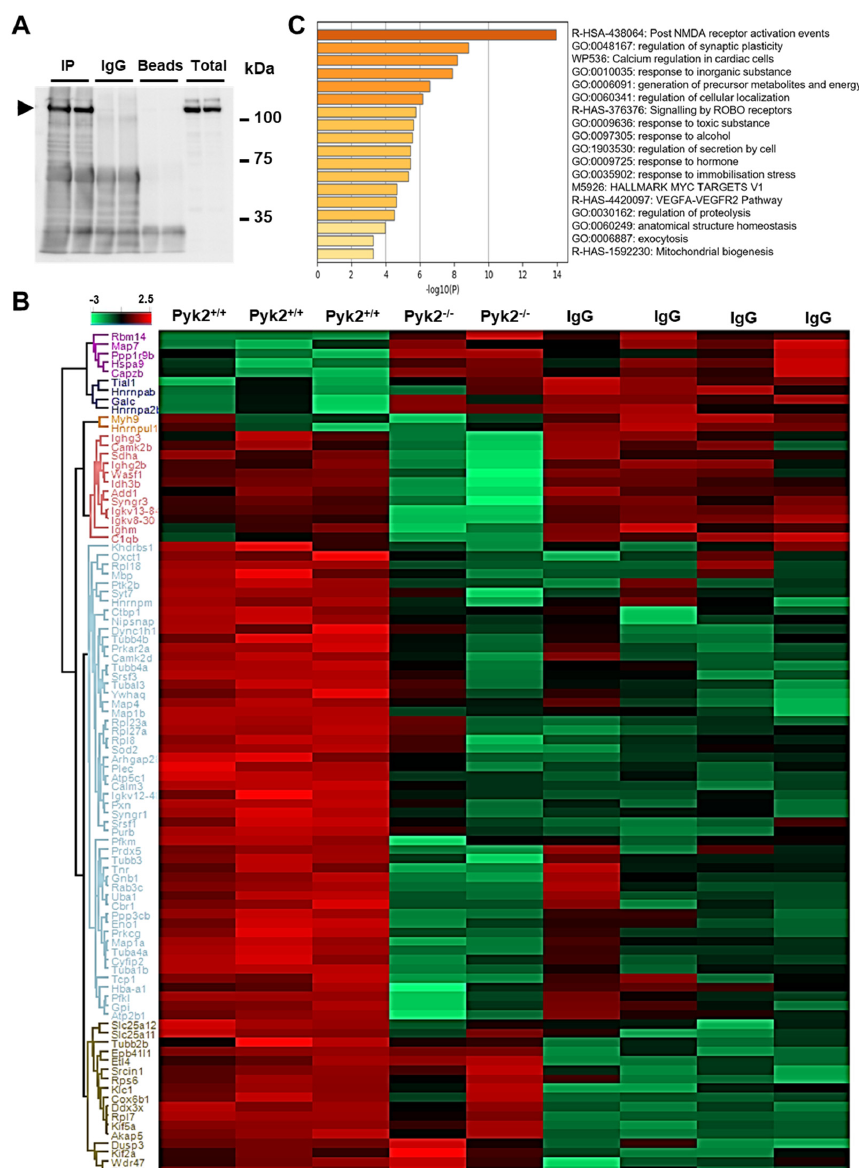
Figure 1. Identification of Pyk2 molecular interactors in the hippocampus. ( A ) Immunoprecipitation (IP) assay was performed in protein extracts from adult (4-month-old) wild-type hippocampal tissue. IgG antibodies were used as a control of the assay and total lysates were added as a control of the antibody immunoreactivity. The arrowhead depicts Pyk2; ( B ) Heatmap representation showing both clustering and the intensity for the immunoprecipitated proteins in each biological condition; ( C ) Statistically enriched biofunctions from Pyk2-associated proteins (from light blue cluster in Figure 1B; see Supplementary Table S2 for details).